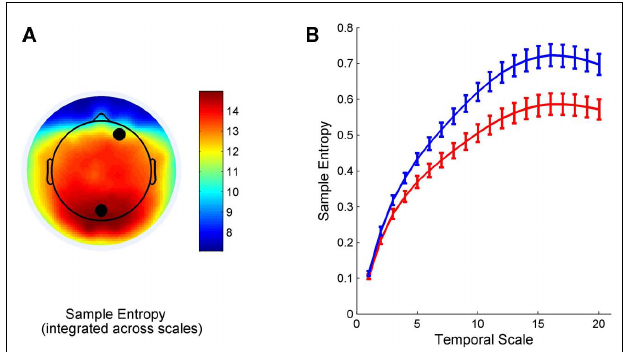
FIGURE 1 | Multiscale entropy curves. Values of S E are summed across temporal scales and the spatial distribution is shown in (A) .The complete multiscale entropy (MSE) curves for two representative channels (marked by black circles), showing S E at each level of coarse-graining, are displayed in (B) . Error bars indicate standard errors of the